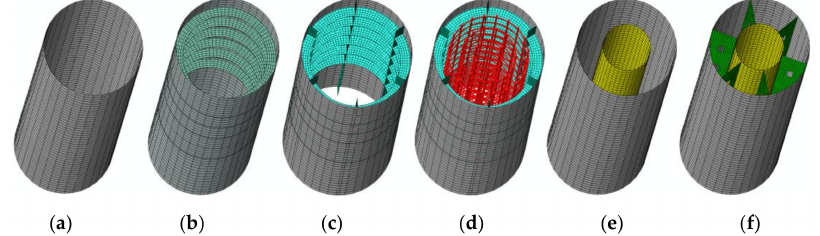
Figure 16. Finite element mesh of steel structure. ( a ) CFST-N; ( b ) CFST-HS; ( c ) CFST-VS; ( d ) CFST-SR; ( e ) CFST-DT; and ( f ) CFST-MC.